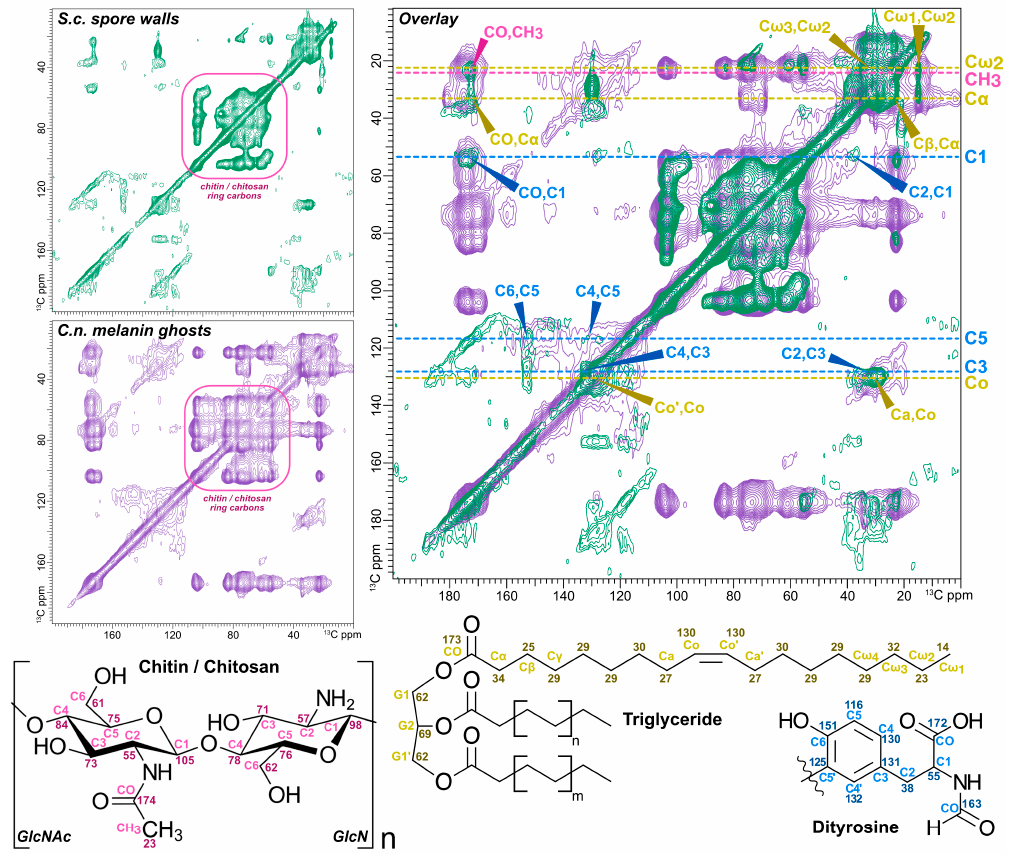
Figure 2. Two-dimensional (2D) 13 C- 13 C dipolar assisted rotational resonance (DARR) ssNMR spectral comparison of outer spore walls isolated from wild type (AN120) S. cerevisiae cells (green spectrum) and melanin ghosts isolated from wild type (H99) C. neoformans cells (purple spectrum), each grown in media containing 13 C-enriched glucose as the sole carbon source. The experiments were conducted using a 500 ms mixing time and therefore display “through-space” correlations between carbon pairs up to ~6 Å apart from one another. Specific carbon resonances are indicated in the overlay of the two spectra. Pink indicates carbons from chitin; blue from dityrosine; yellow from triacylglycerol. Numbers on the structures at the bottom indicate the expected chemical shift for each carbon. As observed for melanin ghosts, correlations corresponding to pairwise interactions between polysaccharide ring carbons (~55–105 ppm) contribute strongly to the spore wall DARR data, including cross peaks that demonstrate the presence of both chitin and its deacetylated product chitosan [46,47]. For instance, the acetyl group of chitin can be identified unambiguously by the unique 13 C chemical shifts of the methyl and carbonyl carbons at ~23 and 174 ppm, respectively. The carbons of this covalently bonded pair are correlated with one another (23 × 174 ppm) and also to the